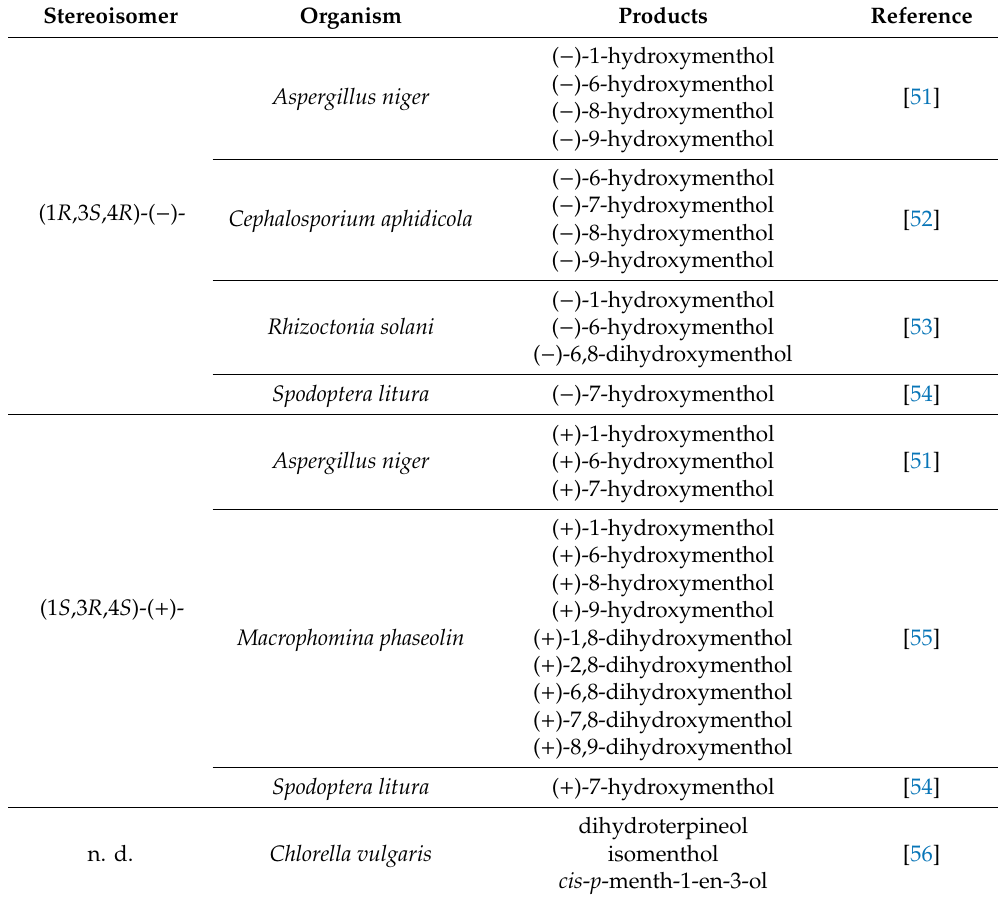
Table 6. Biotransformation of